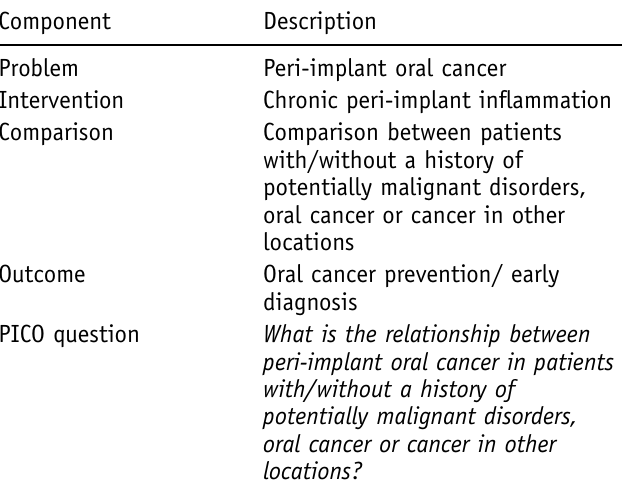
Table I. PICO question